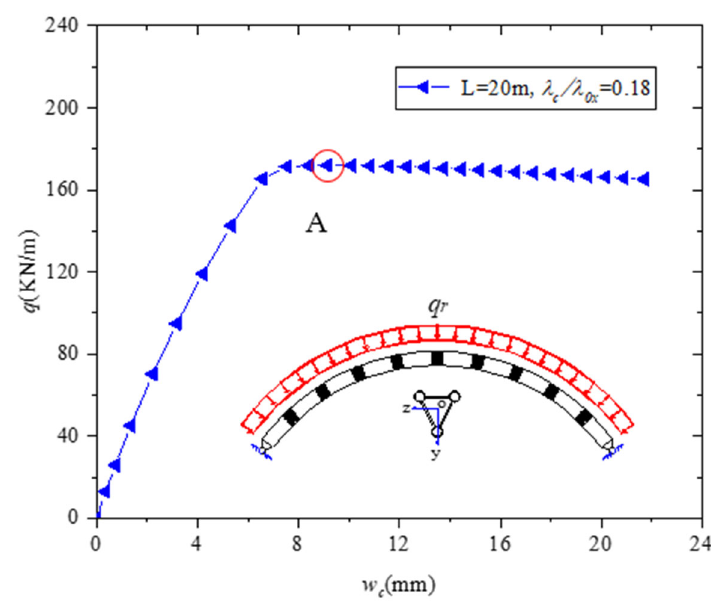
Figure 11. Load–displacement curve of the vault under uniform radial load.